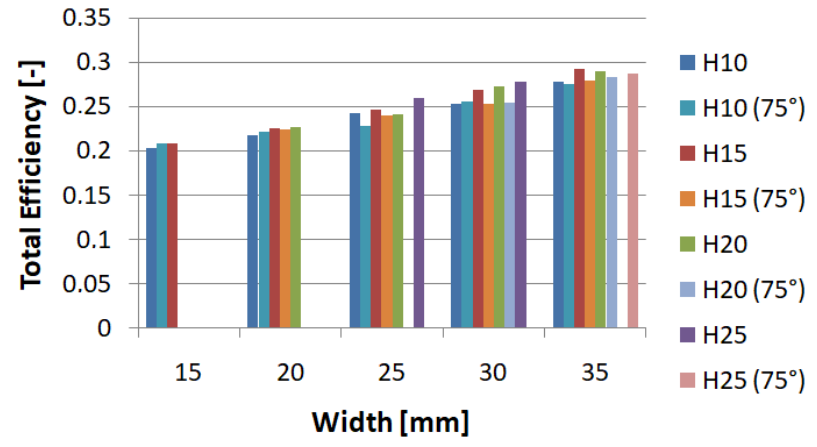
Figure 6. Value of the total efficiency indicator for the model with hexagonal trigger.